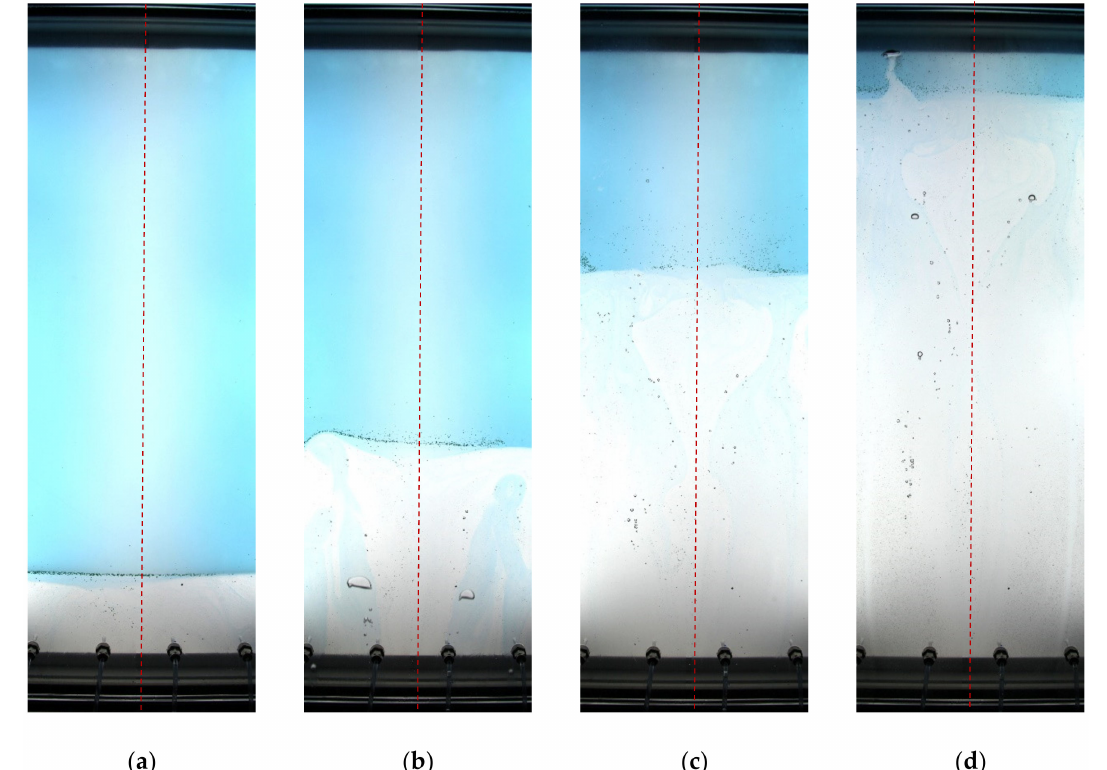
Figure 9. Snapshots of displacement flow in test no. 5: ( a ) t = 0 s; ( b ) t = 4 s; ( c ) t = 8 s; ( d ) t = 12